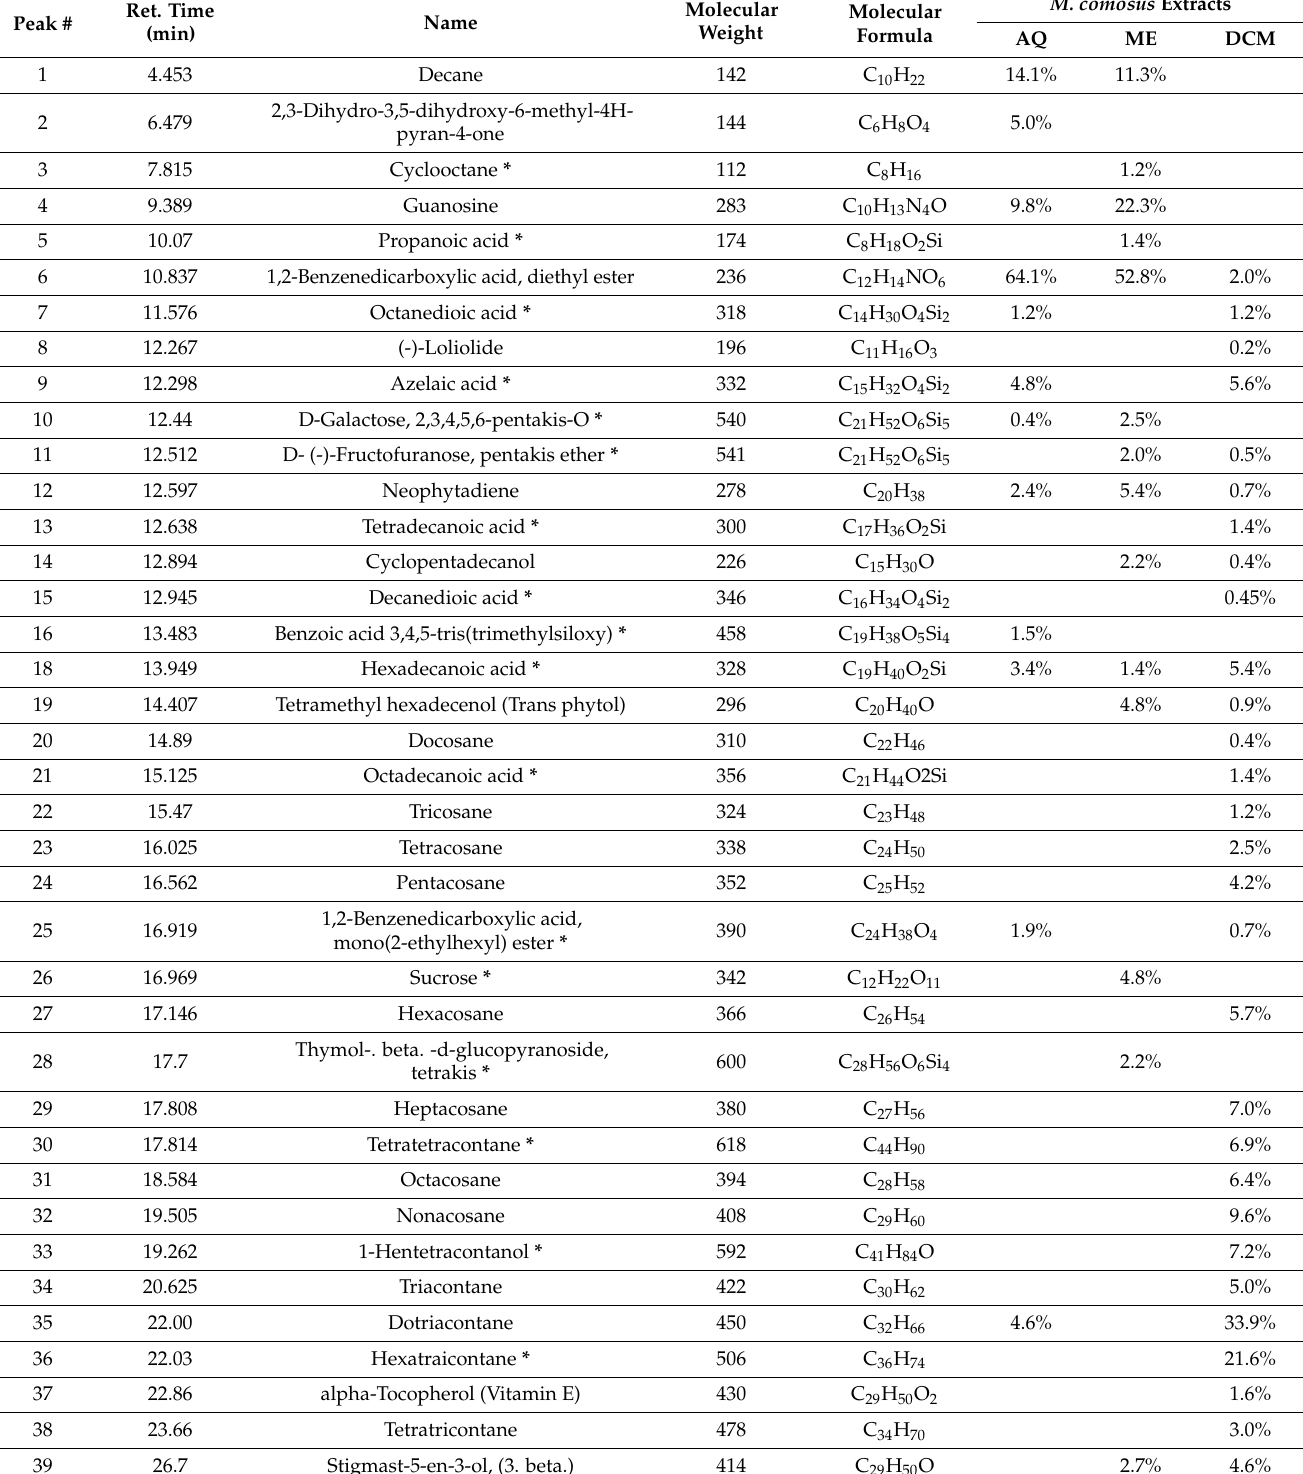
Table 1. GC-MS spectral analysis of Melianthus comosus (aqueous, methanol and dichloromethane) extracts. Ret. Time Peak #